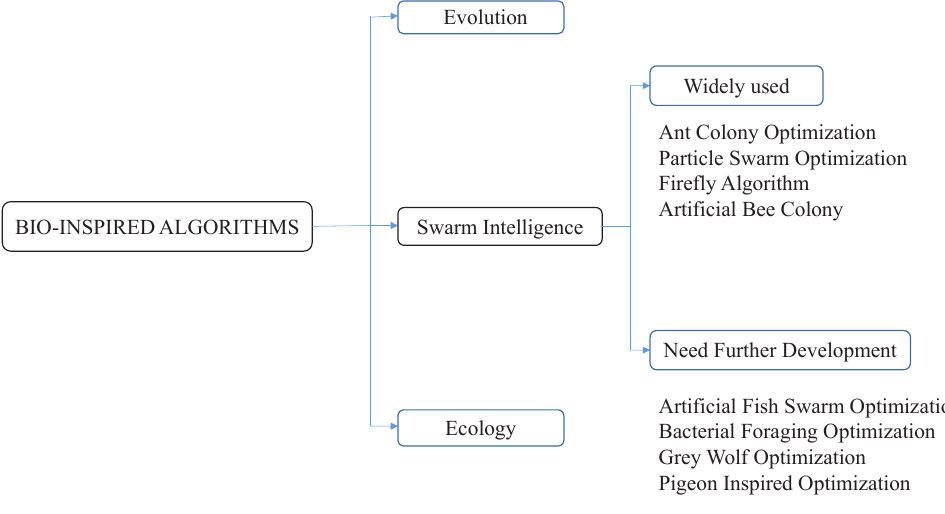
Figure 4. Bio-inspired optimization